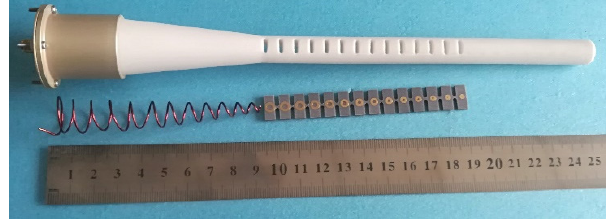
Figure 11. Fabricated parts of Embedded Helix and dielectric rod antenna.